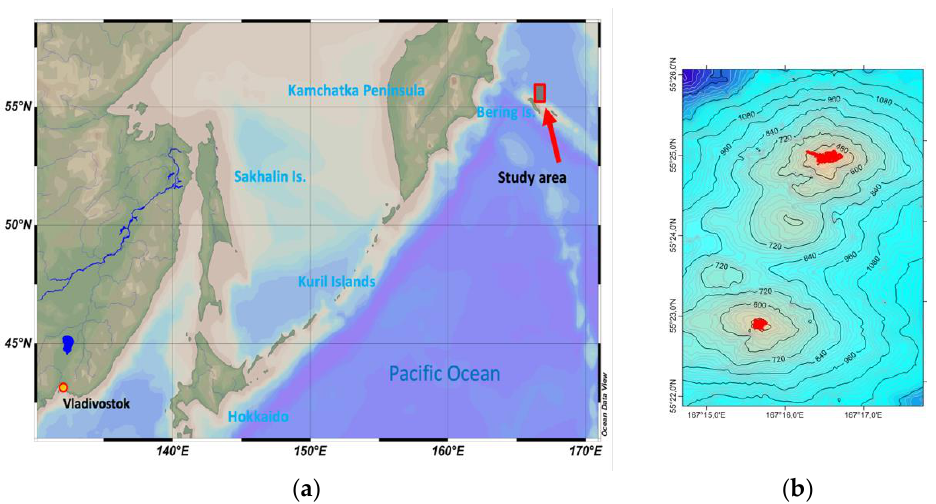
Figure 1. Location of the submarine Piip Volcano in the in the rear of the Aleutian Islands’ arc, the south-eastern Bering Sea ( a ), and bathymetry of its northern and southern tops ( b ). The red patches indicate areas covered with bacterial mats marking the diffuse seepage.